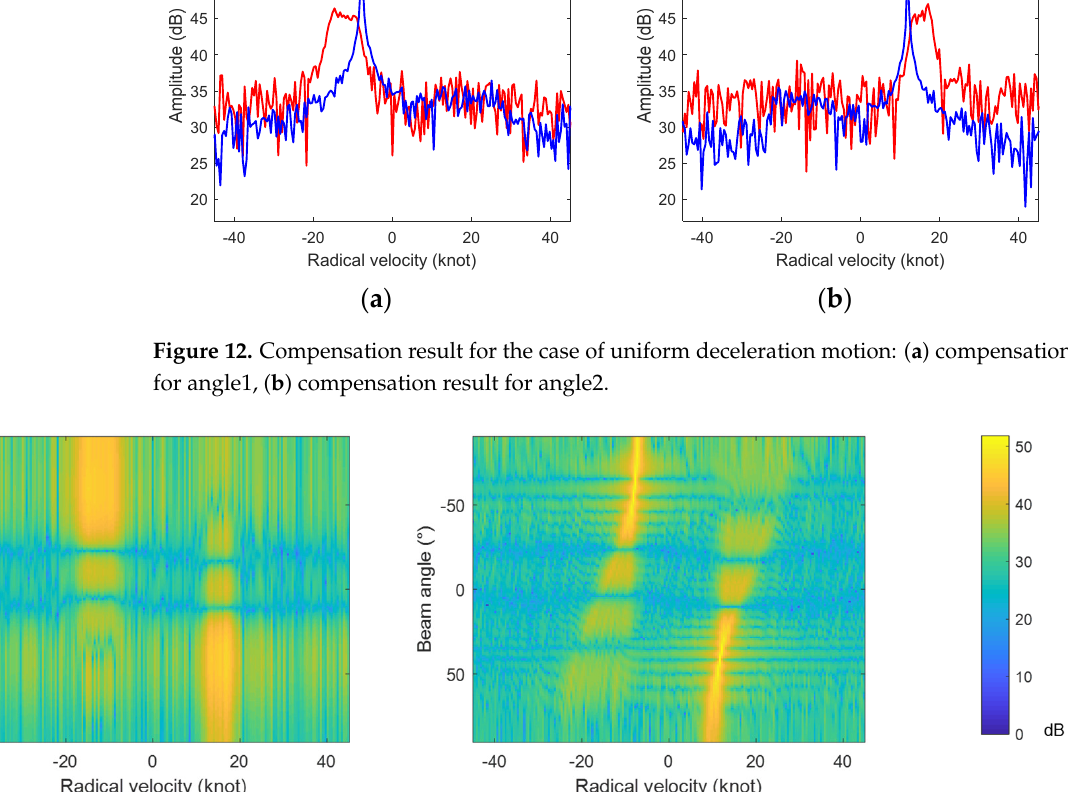
Figure 13. Space–time two-dimensional spectrum before and after motion compensation for case of uniform deceleration motion: ( a ) results before motion compensation, ( b ) results after motion compensation.